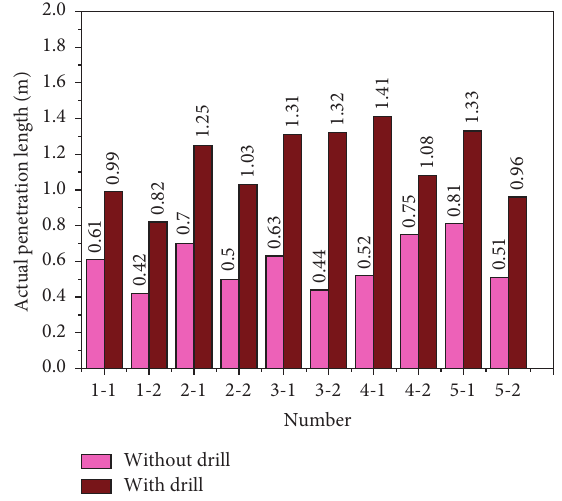
Figure 23: 51mm-in-diameter bolt penetration depth